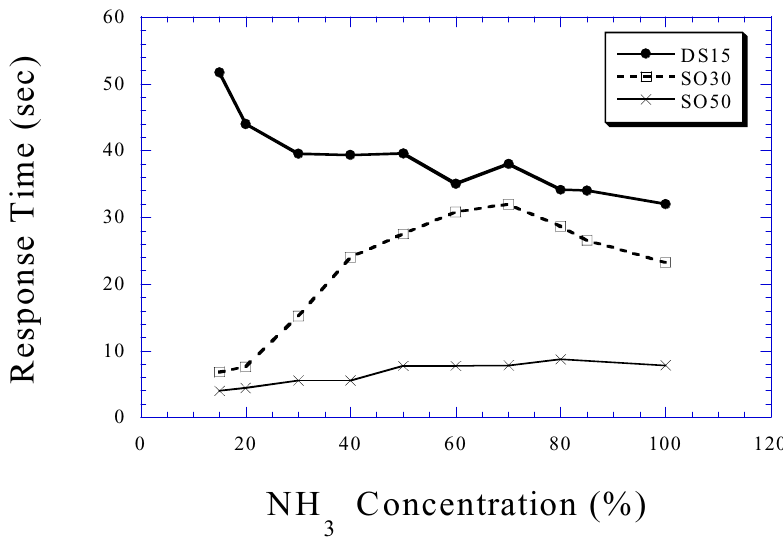
Figure 19. Sensor recovery times changing from an ammonia environment to an argon